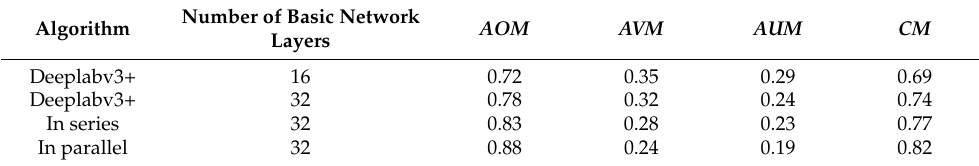
Table 7. Multiple coastlines extraction effect.